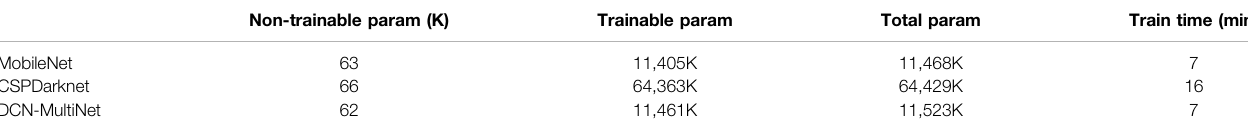
TABLE 1 | Model parameters of different backbone networks.